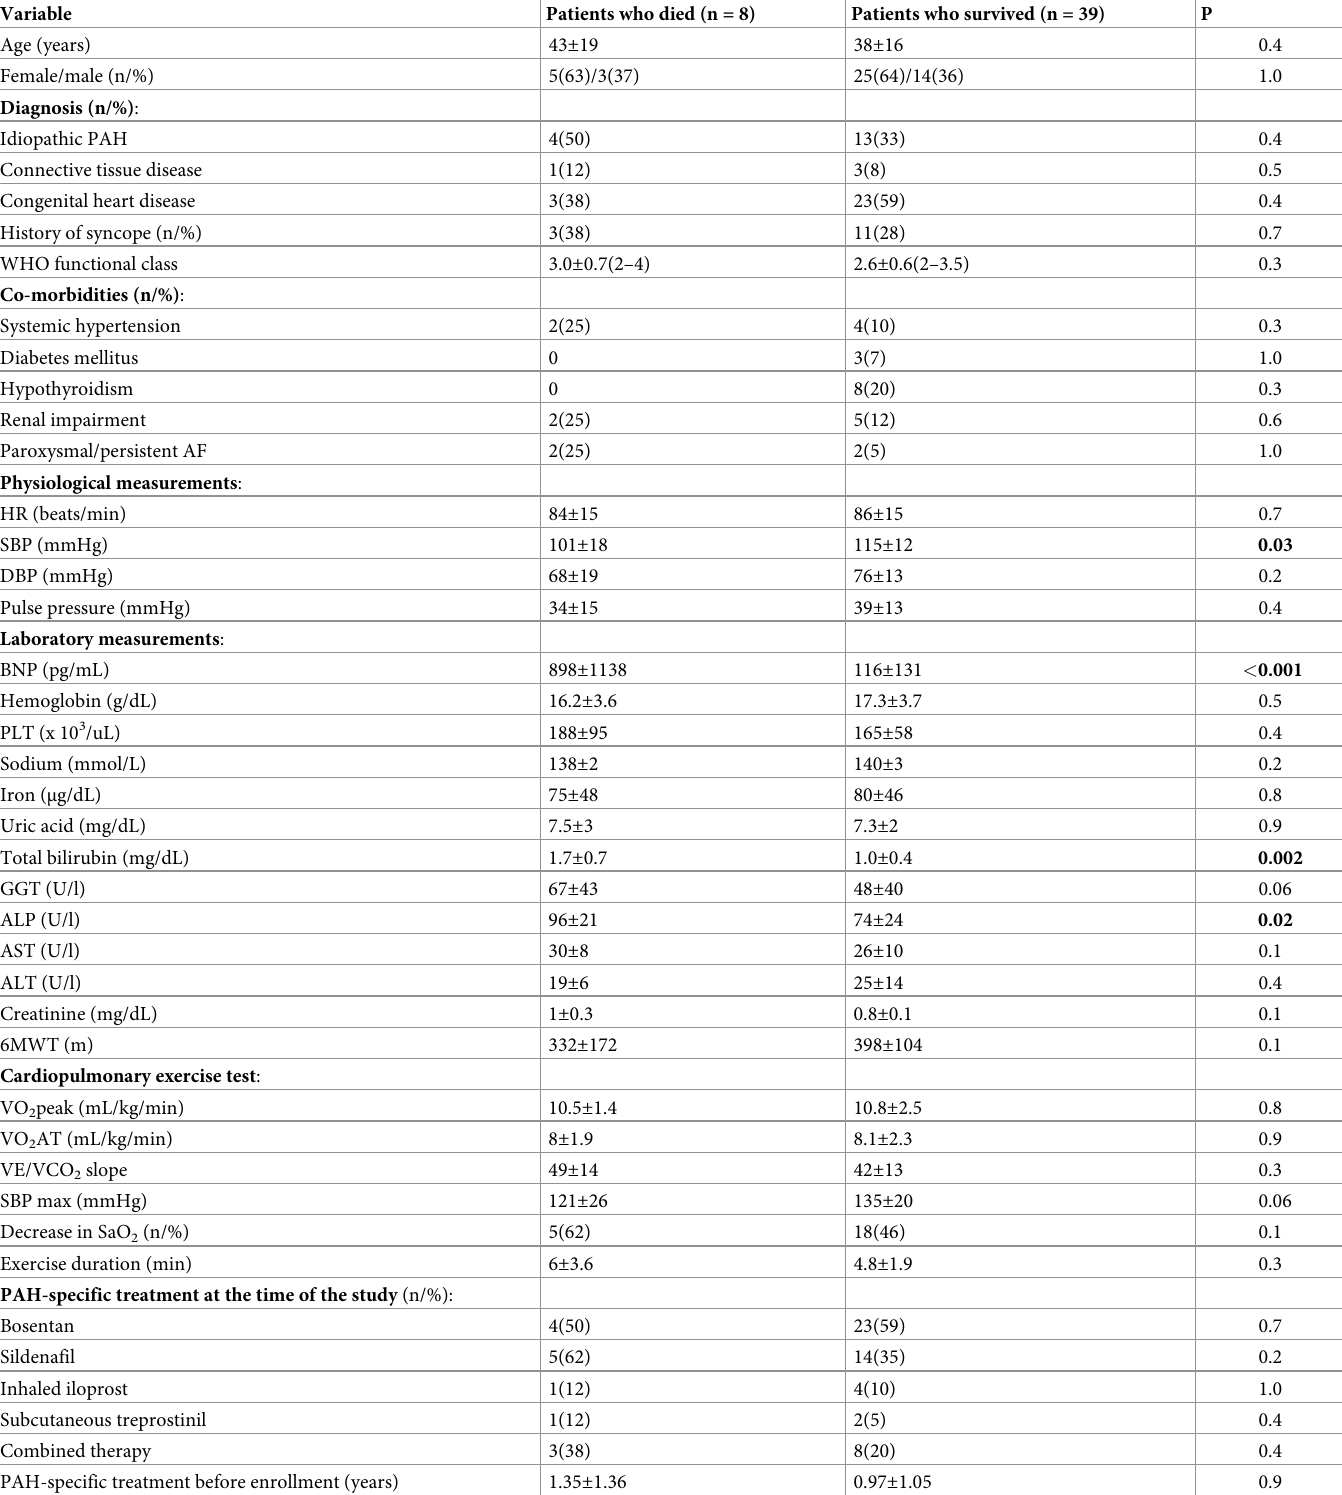
Table 1. Baseline clinical characteristics of patients with pulmonary arterial hypertension (PAH) who died or survived during